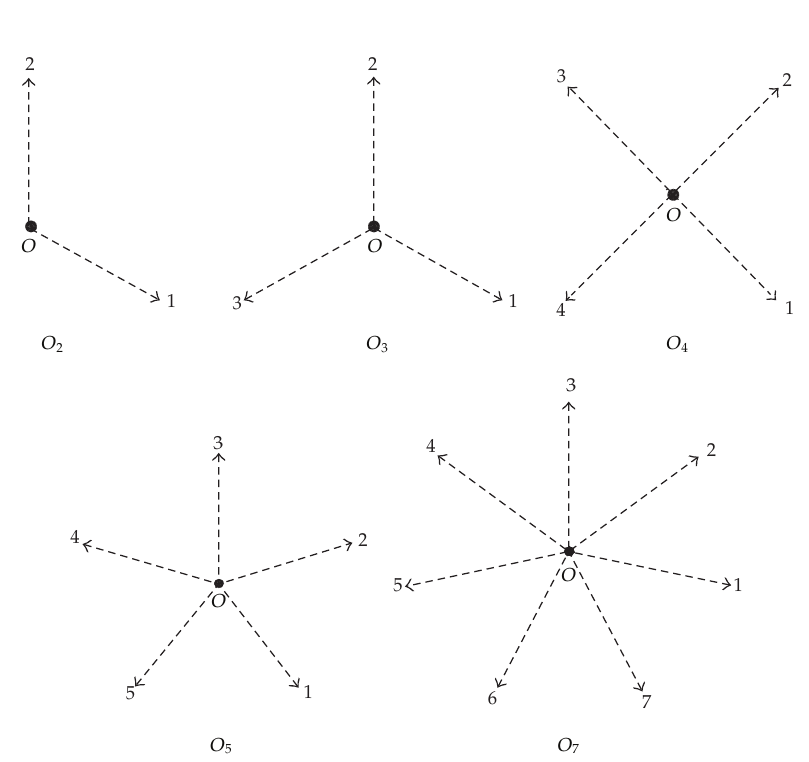
Figure 13: Generalized coordinate